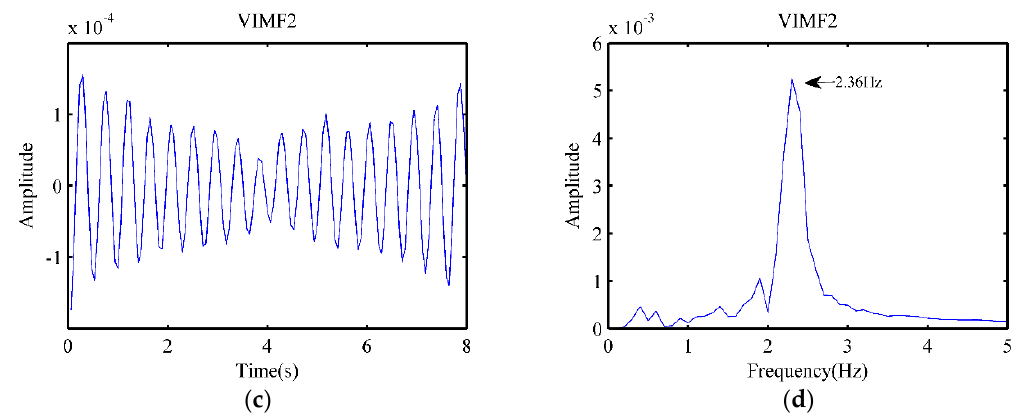
Figure 6. Results after the variational mode decomposition (VMD). ( a ) The waveform of VIMF1; ( b ) The spectrum of VIMF1; ( c ) The waveform of VIMF2; ( d ) The spectrum of VIMF2.